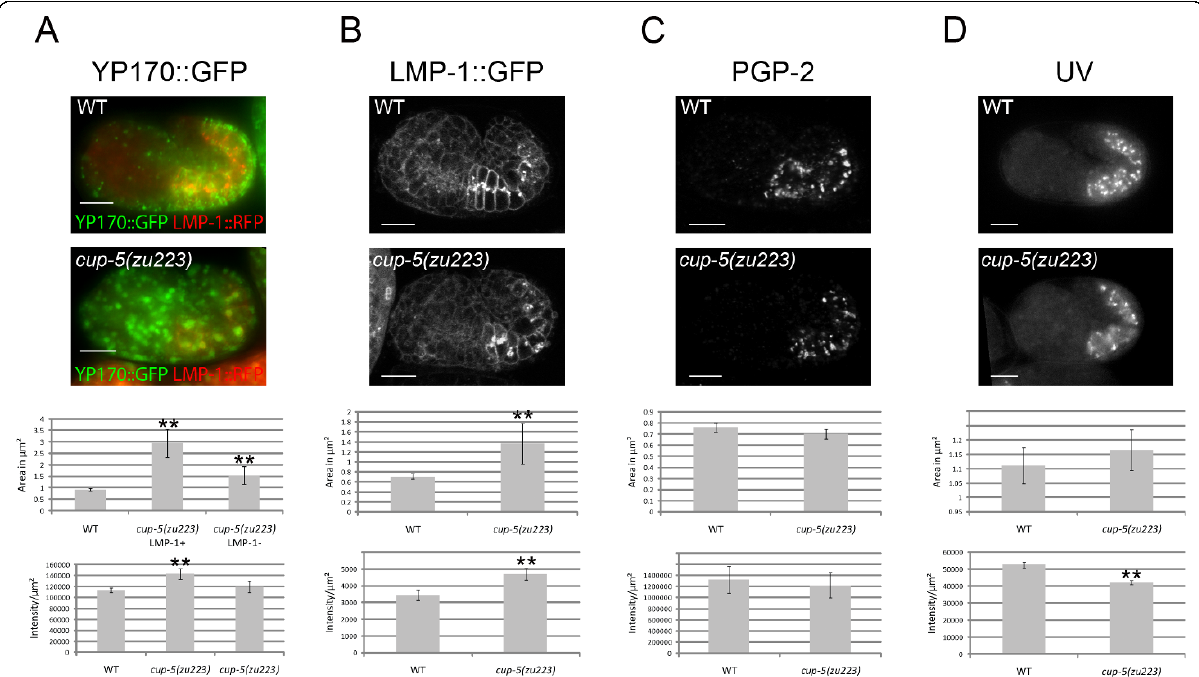
Figure 4 cup-5 mutant effects on sizes and intensities of markers of late endocytic and lysosome-related organelles in developing intestinal cells . Images of wild type and cup-5(zu223) embryos, as well as quantification of sizes and intensities per unit area of compartments with YP170::GFP (A), LMP-1::GFP (B), PGP-2 (C), and UV (D) signals. Images for the same marker were taken using the same microscopy parameters. Scale bars represent 10 μ m. Error bars represent the 95% confidence intervals for significance, and asterisks represent statistical significance at p < 0.05, compared to WT. In cup-5(zu223) embryos, the difference in areas of YP170::GFP organelles (A) with or without LMP-1:: TagRFP(S158T) is also statistically